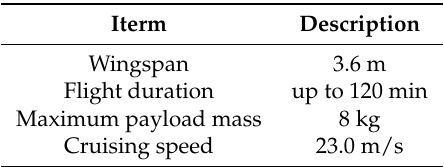
Figure 3. UAS “xiangfei” platform. Table 1. The technical specification of